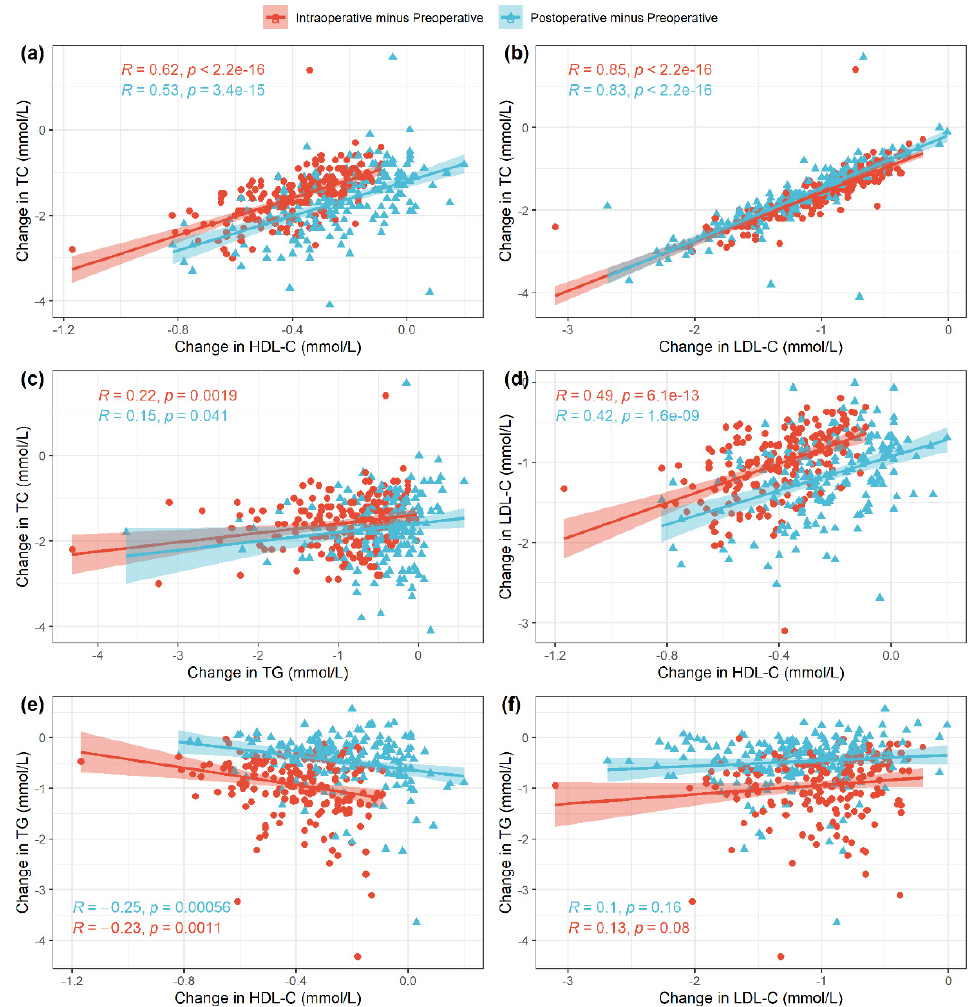
Figure 2. Pairwise associations across the different variables with associated Pearson correlation coefficients and p ‐ values: TC and HDL ‐ C ( a ), TC and LDL ‐ C ( b ), TC and TG ( c ), LDL ‐ C and HDL ‐ C ( d ), TG and HDL ‐ C ( e ), TG and LDL ‐ C ( f ). For each patient, the changes from preoperative to intraoperative values (red) and from preoperative to postoperative values (blue) are shown.